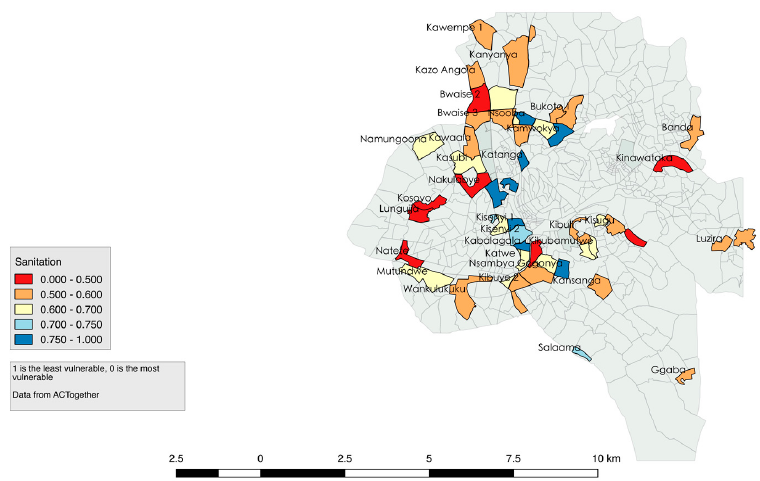
Figure 4. Sanitation Vulnerability; Created with QGIS using variables in Table 1. 49 out of 57 slum communities have a water vulnerability score of under 0.75 (1 is least vulnerable and 0 is most vulnerable). The geographical units portrayed are Ugandan village boundaries.